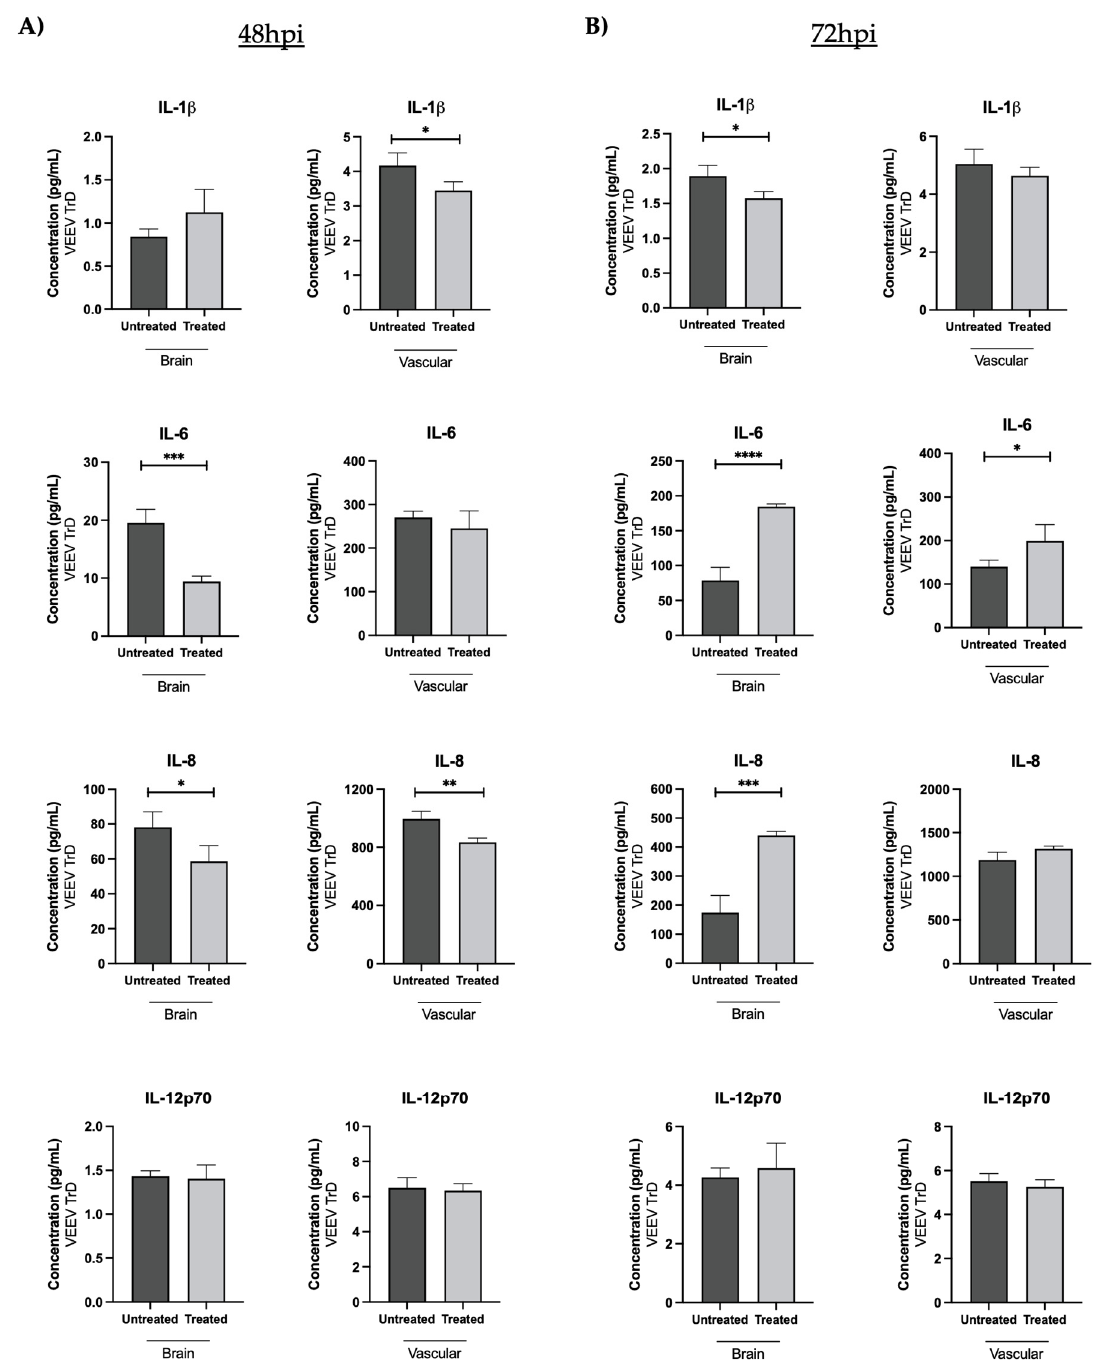
Figure 8 . Effect of OMA treatment on proinflammatory cytokines in the gNVU in the context of VEEV TrD infection. Perfused media from the brain and vascular compartments of the gNVUs that were either infected, untreated (untreated) or infected, treated (treated) obtained at 48 h ( A ) or 72 h ( B ) post infection were assessed by multiplexed ELISA for the levels of 10 proinflammatory cytokines. Four of the cytokines that demonstrated outcomes with statistical significance at either of the time points are included here (IFN- γ , IL-1 β , IL-6, IL-8). Each sample was queried as technical duplicates in the ELISA and the data were averaged for each analyte at the two time points. The overall average of the biological replicates was obtained and represented as pg/mL concentration for each cytokine. Statistical analysis was carried out using t -test * p < 0.05, ** p < 0.01, *** p < 0.001, **** p < 0.0001.